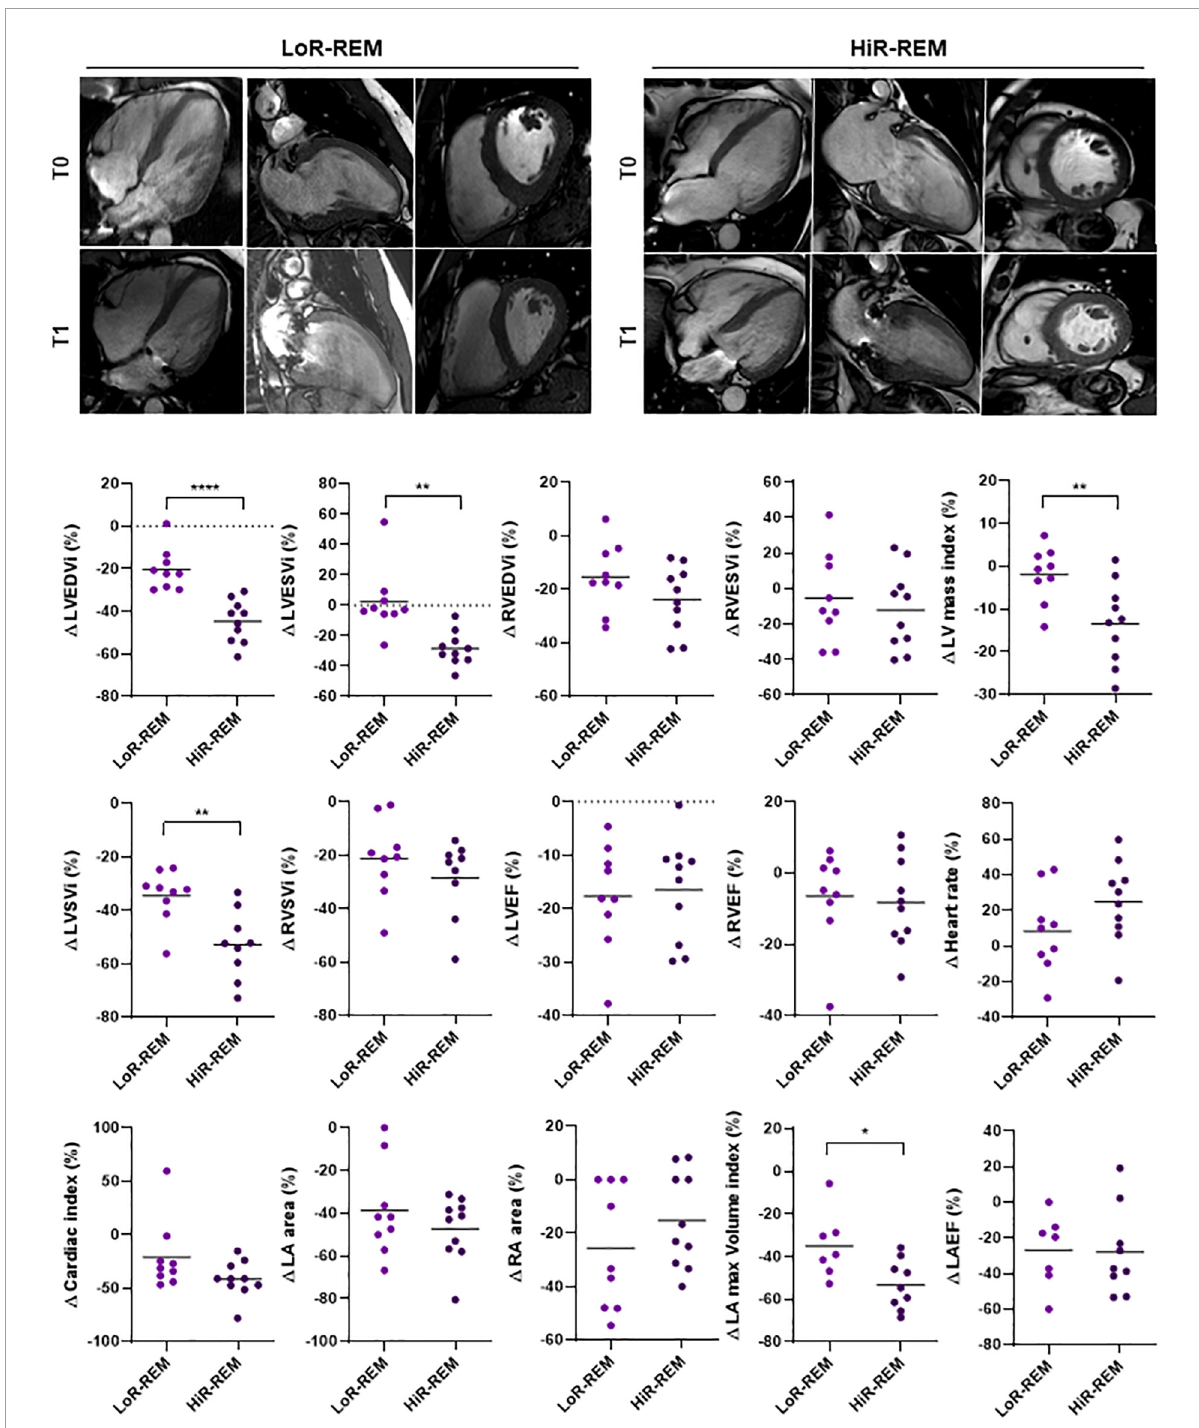
FIGURE2 Analysis of CMRI parameters change in MR patients with different grade of reverse remodeling after MVR surgery. The CMRI data were collected from patients undergoing MVR surgery ( n = 19) before (T0) and 6 months after (T1) surgery. The CMRI acquisitions are shown for a representative Low LV reverse remodeling (LoR-REM) and High LV reverse remodeling patient (HiR-REM). For each CMRI parameter measured, the percentage change between T0 and T1 was computed for each patient as % (cid:49) = (T1 – T0)/T0 × 100. The data are compared between LoR-REM and HiR-REM patients. Individual data are shown; horizontal bars represent group average. Statistical significance of the differences was evaluated by independent samples Student’s t -test (with or without Welch’s correction) or the Mann–Whitney test depending on data distribution. * p < 0.05; ** p < 0.01; **** p <